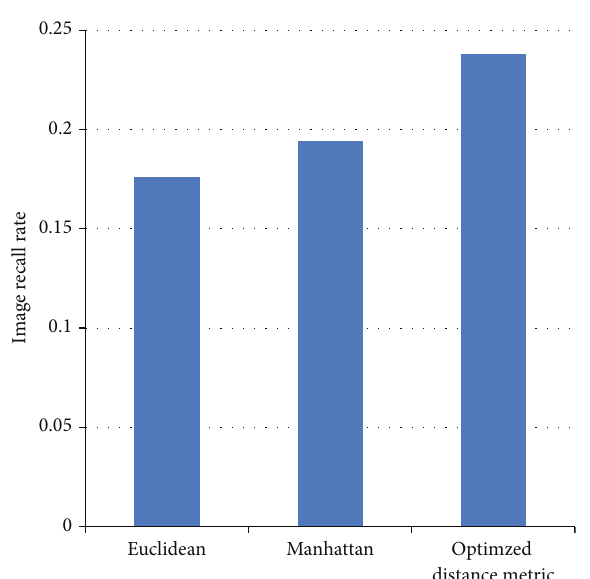
Figure 12: Elephant image recall rate comparison.